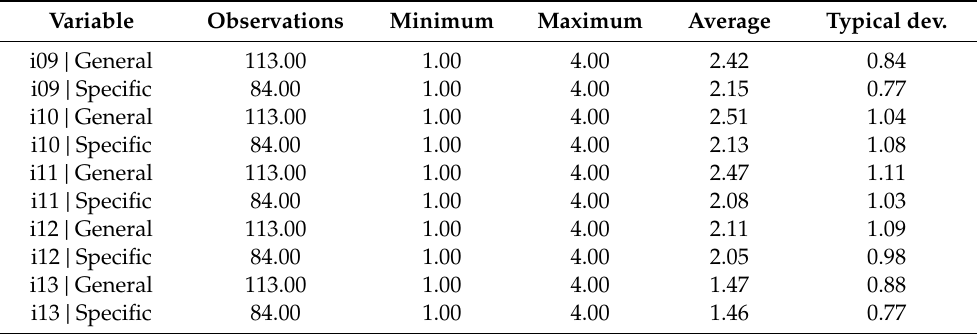
Table 10. Average differences between the items concerning the educational design of the program according to whether the descriptor appears generally or specifically.